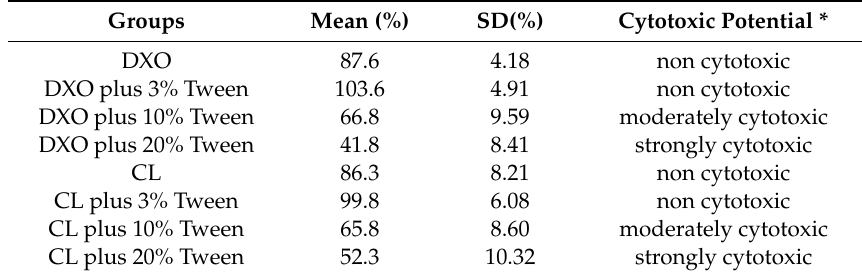
Table 2. The cytotoxicity results measured by the WST-1 (2-(4-iodophenyl)-3-(4-nitrophenyl)-5- (2,4-disulfophenyl)-2H-tetrazolium) assay.